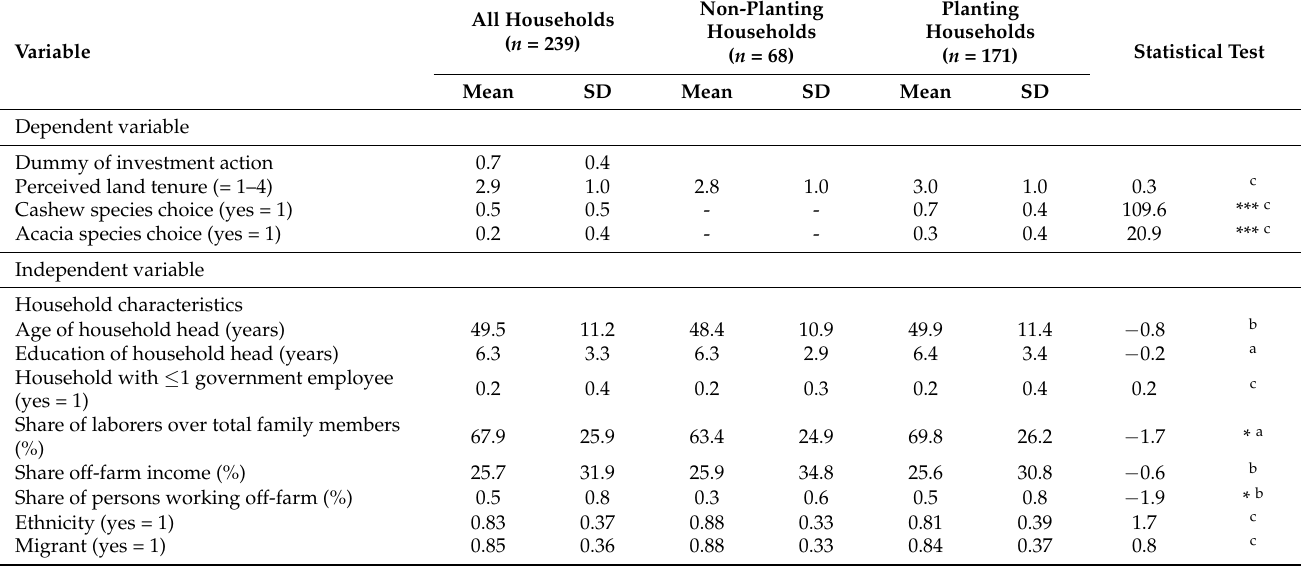
Table A2. Descriptive statistics of dependent and independent variables ( n =